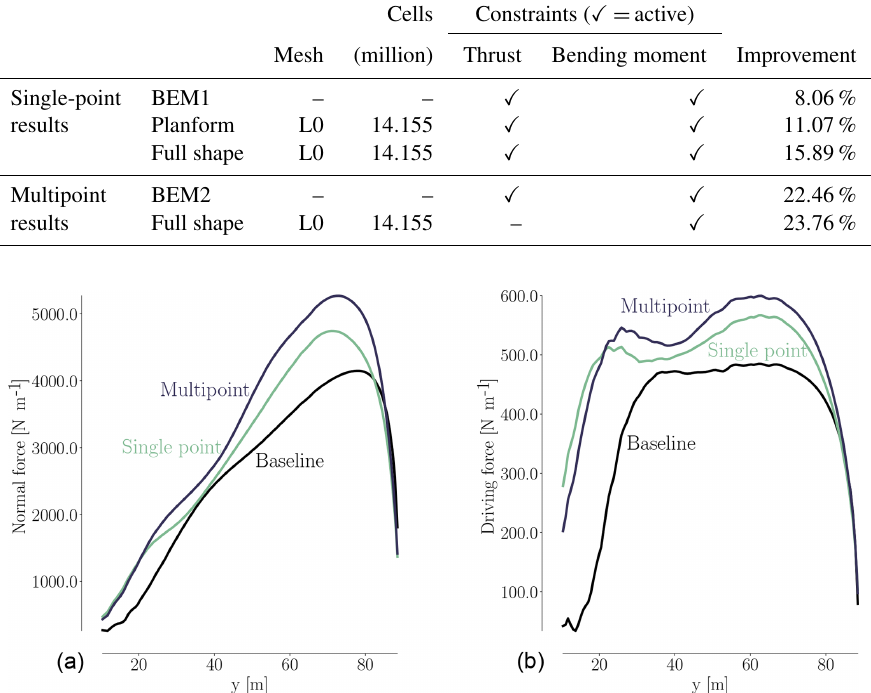
Figure 20. Comparison of normal (a) and driving (b) forces for baseline and optimized designs. The shape optimization increases the normal force, and the peak has also moved further inboard. The driving force is increased considerably both at the root and close to the tip